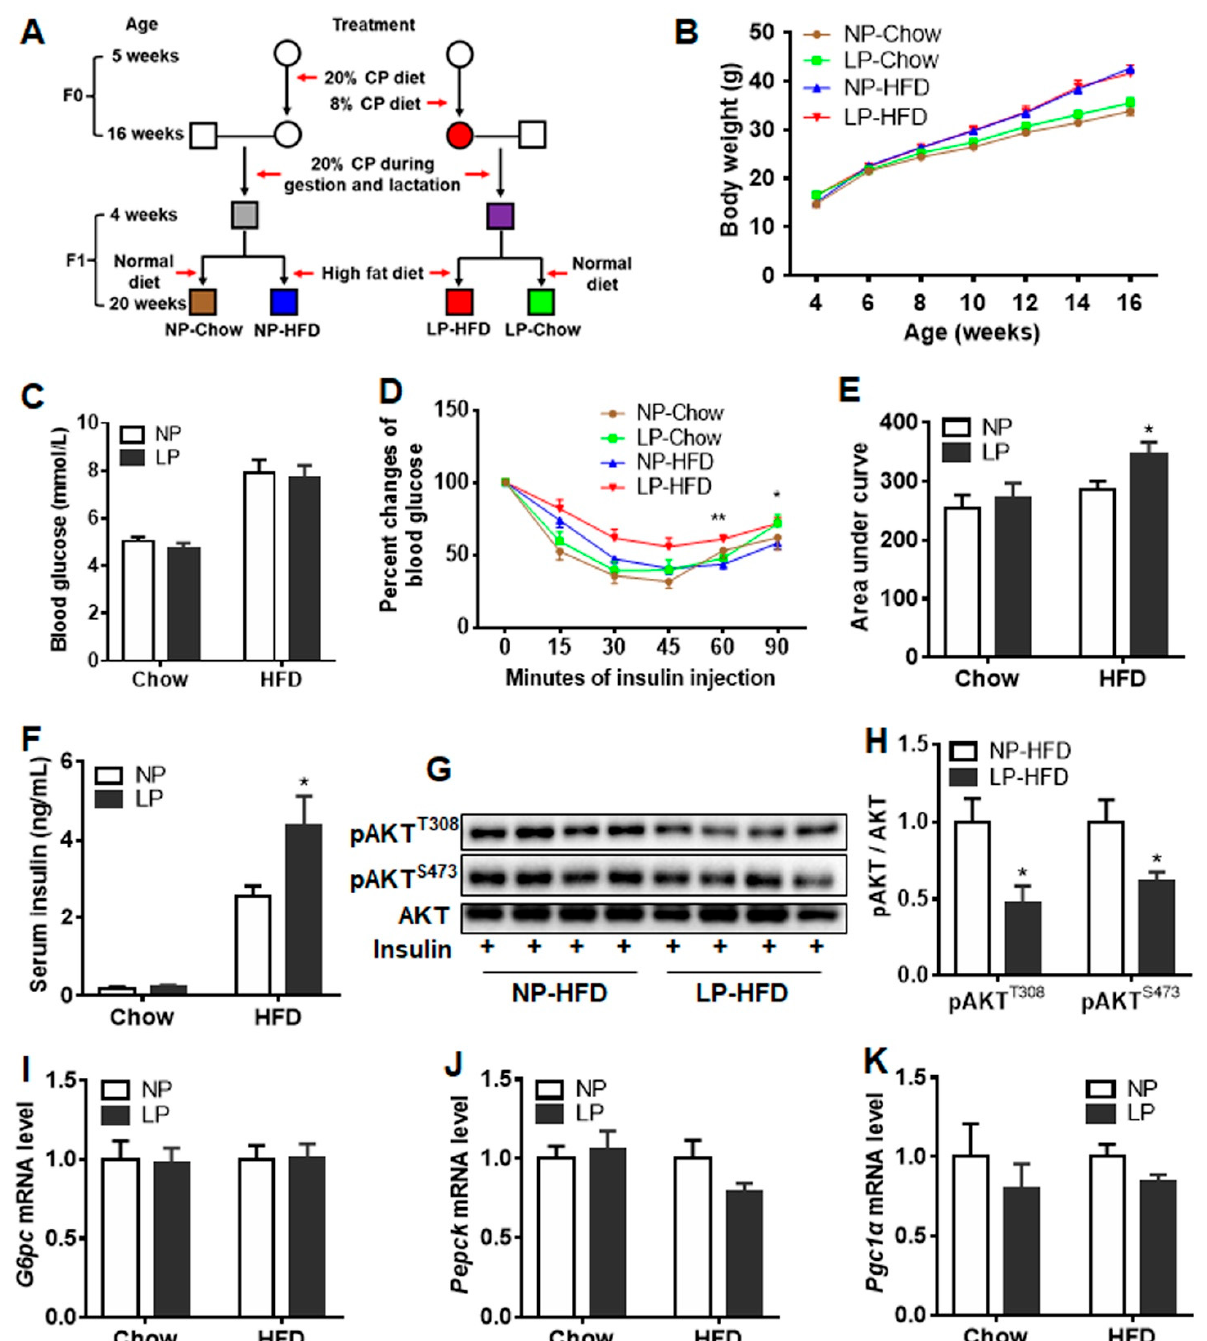
Figure 1. Maternal low-protein diet during puberty and adulthood impaired insulin sensitivity of offspring under HFD condition. C57/BL6J female mice were fed with NP diet or a LP diet for 11 weeks until 16 weeks of age. These mice were then mated with normal-diet fed male mice. All female mice were fed with normal-diet during pregnancy and lactation. F1 male pups were weaned at 3 weeks of age and then were accessed to normal chow diet or high-fat diet from 4 weeks of age. ( A ) Breeding strategy to generate the first-generation offspring. ( B ) Body weight of the offspring ( n = 10–14 for each group). ( C ) Blood glucose levels at harvest ( n = 7–9 for each group). ( D ) Insulin tolerance test and ( E ) the area under curve ( n = 7 for each group). ( F ) Insulin levels in the serum ( n = 6 for each group). ( G ) Western blot bands of phosphorylation AKT in liver tissue. ( H ) The quanti- fication of phosphorylation AKT levels. The mRNA levels of G6pc ( I ), Pepck ( J ), and Pgc1 α ( K ) in the